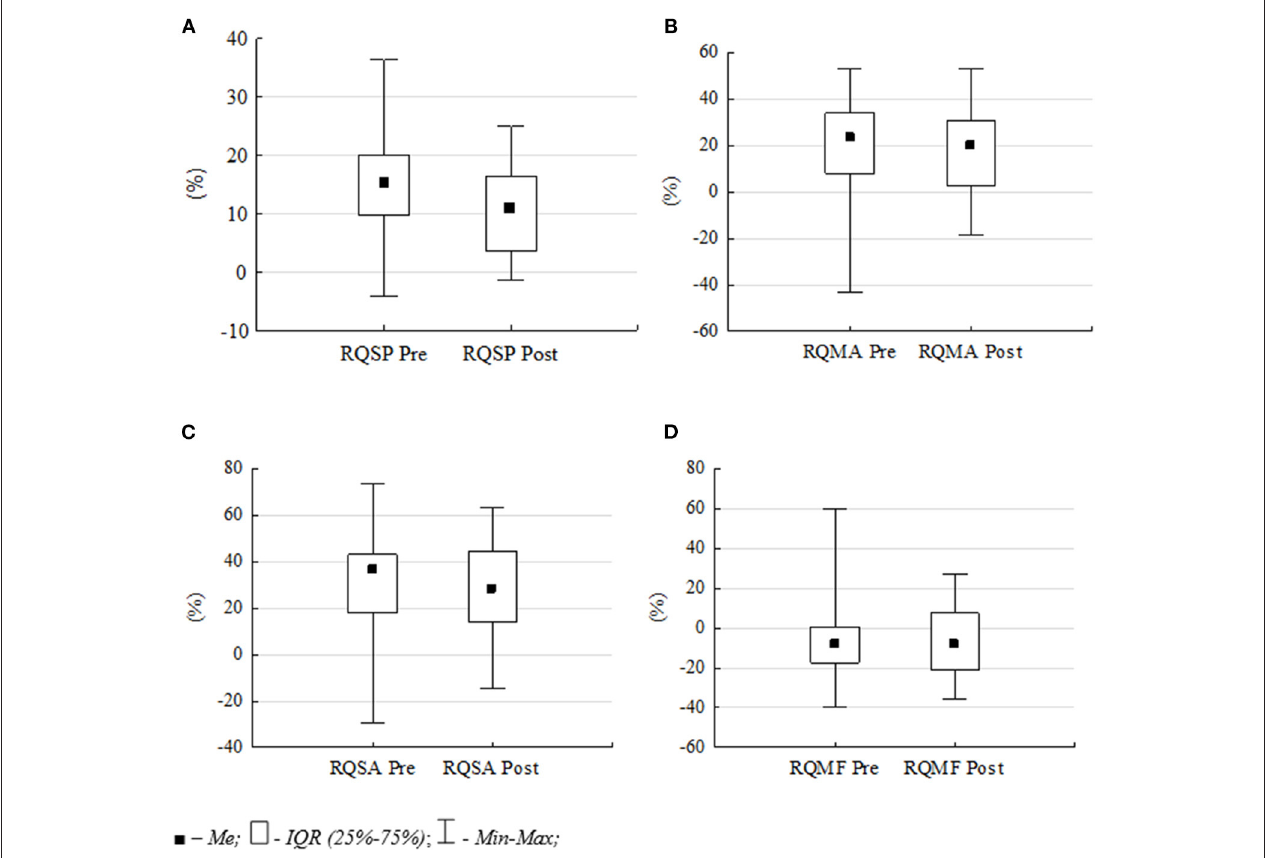
FIGURE 3 | Differences in pre- and post-exposure normalized Romberg quotients: (A) RQSP, (B) RQMA, (C) RQSA and (D) RQMF. Data are median Me, inter-quartile range IQR , Min and Max values